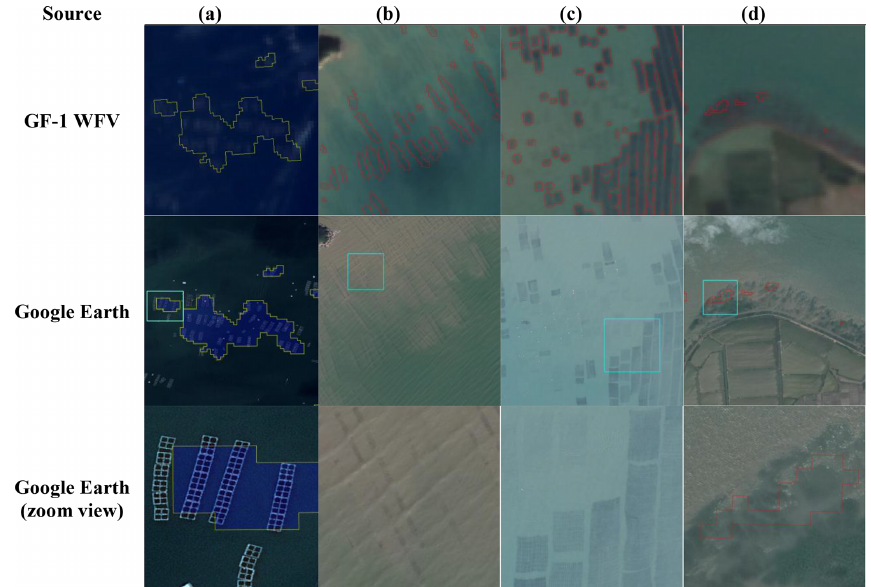
Figure 8. Illustration of potential sources of error in the HCHNet algorithm: the boundaries of relatively small and separate MAC (a) or MPA (b) areas are difficult to accurately identify. (c) Harvested MPC areas are also difficult to detect due to shallow waters and the disappearing dark tone. (d) Vegetation located close to the water bodies may be misclassified as MPC areas. The first row highlights typical misclassified areas from GF-1 WFV data. The second row shows high-spatial-resolution images from Google Earth (© Google Maps). The third row is a zoom view of the Google Earth images in the second row (© Google Maps). The red and yellow areas indicate the classification results of MPC and MAC areas,